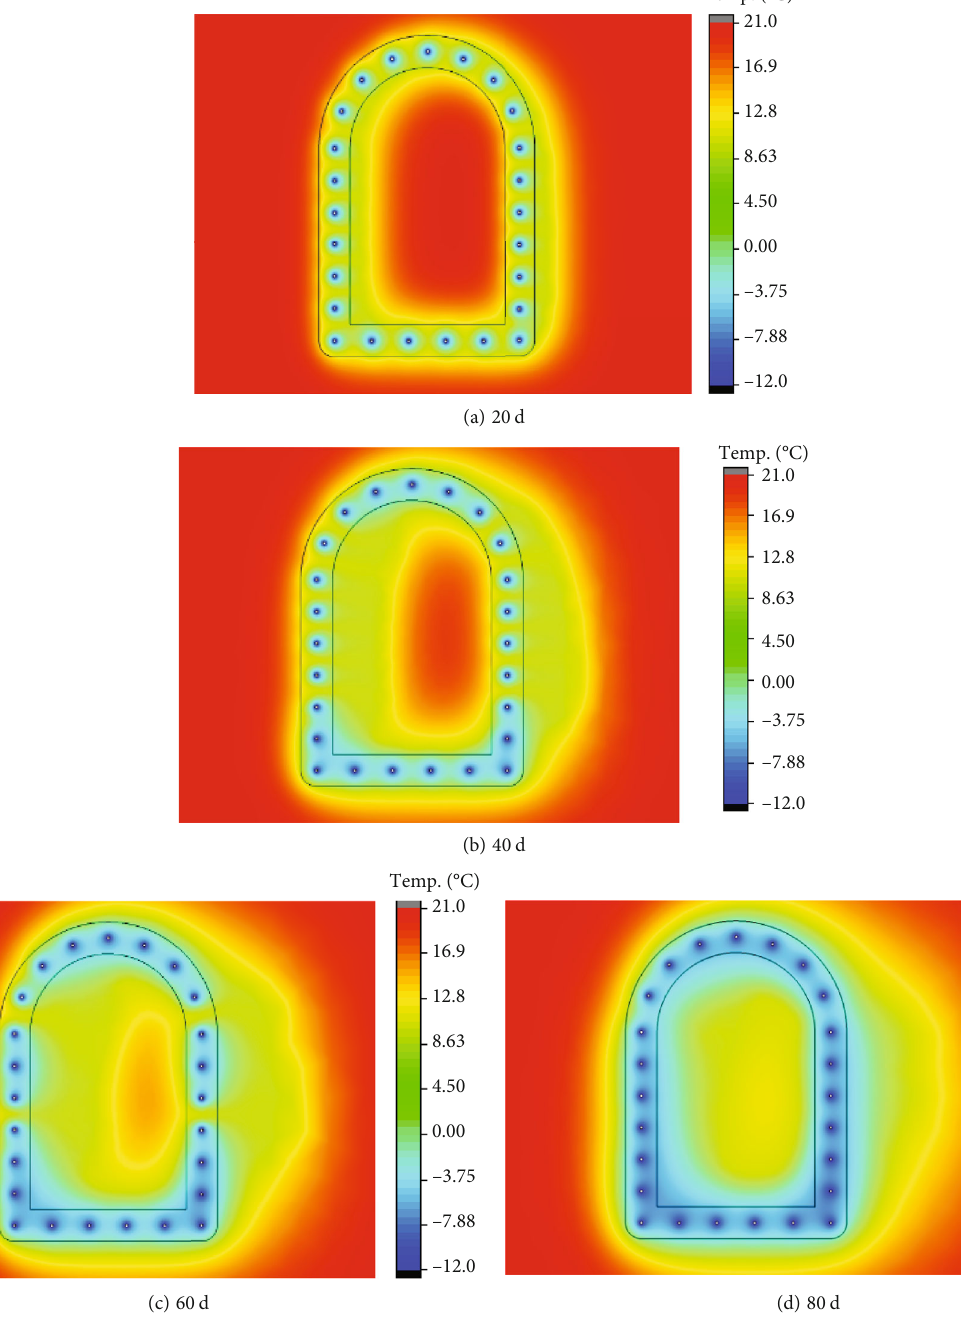
Figure 4: Gravel formation temperature fi eld at di ff erent freezing